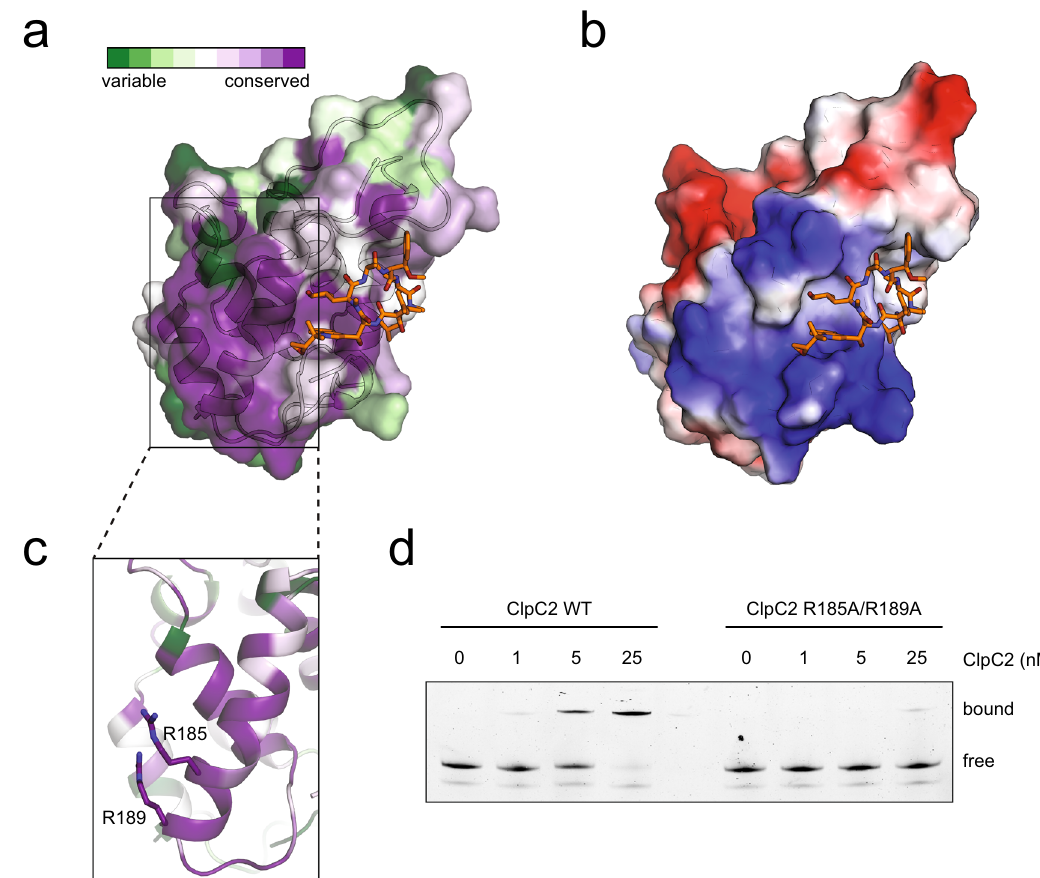
Fig. 5 CymA interferes with Mtb ClpC2 binding to its promoter DNA. a Surface representation of ClpC2 94 – 252 -CymA coloured according to residue conservation produced using ConSurf 60 – 62 . CymA is coloured in orange and shown in stick representation. b Structure of ClpC2 94 – 252 depicting surface charge and shown in the same orientation as in a . c Close-up of the suggested DNA recognition helix shown in the forefront. Arginines suggested to contribute to DNA-binding are shown in stick representation. d Comparison of ClpC2 WT and ClpC2 R185A/R189A double mutant in an electrophoretic mobility shift assay. ClpC2 variants were titrated against 0.5 nM DNA probe and loaded onto a 12% polyacrylamide gel. Data are representative of three independent